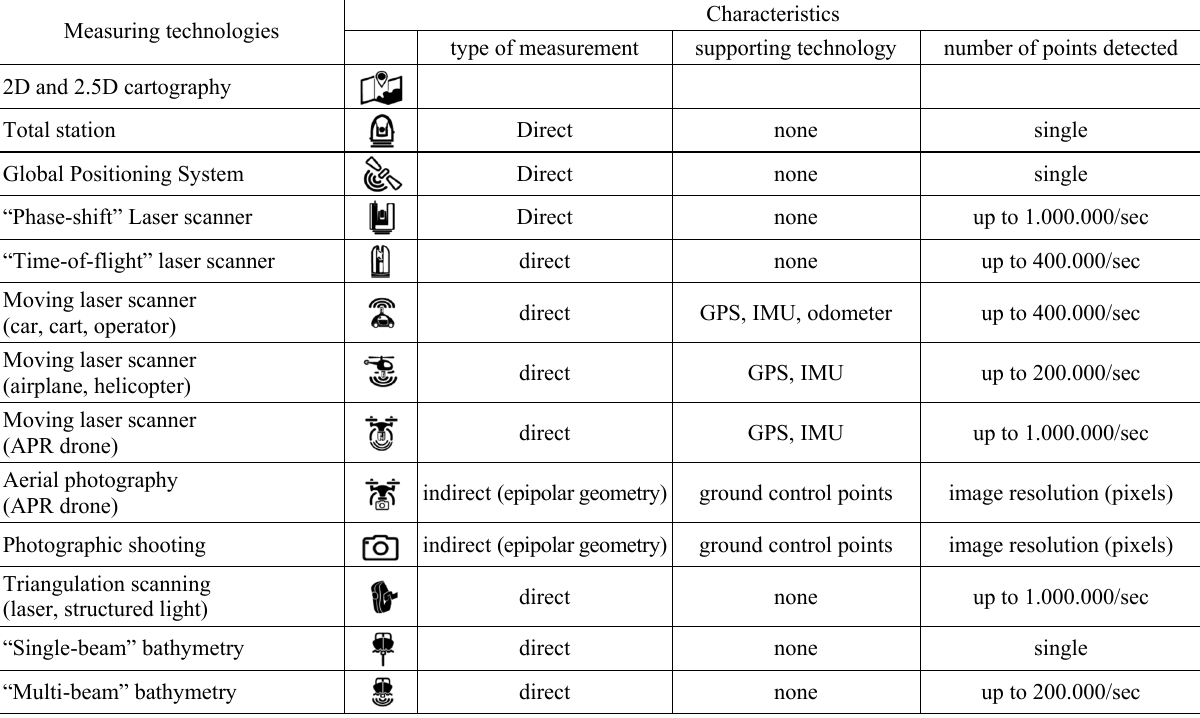
Table 1. Types of acquisition tools, characteristics and scope of